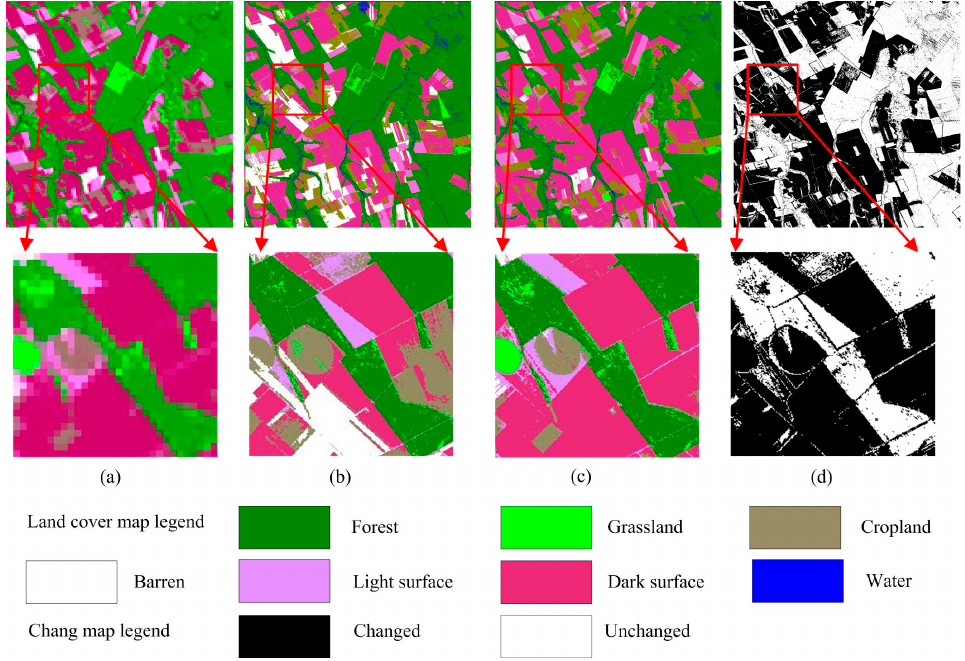
Figure 7. The data used in experiment 2: ( a ) coarse resolution image (degraded image); ( b ) former finer-resolution land cover map; ( c ) latter finer-resolution land cover map (reference map); and ( d ) change map.